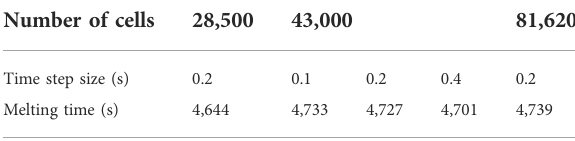
TABLE 3 Effect of grid size and time step size on the charging